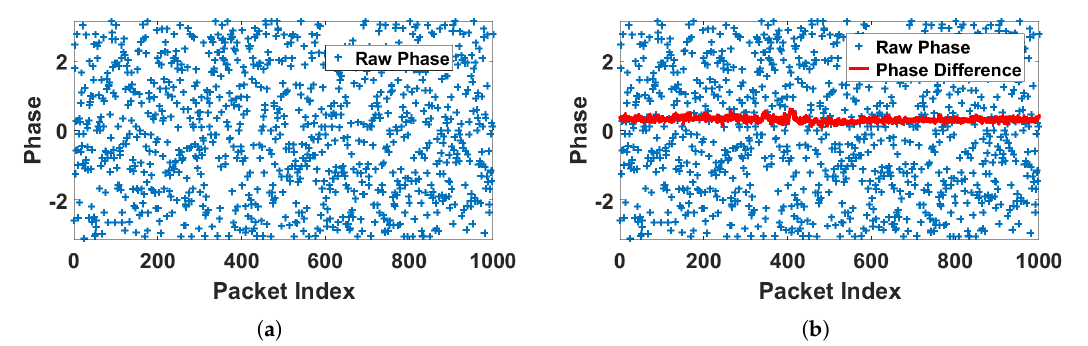
Figure 6. Raw phase and phase difference when no human appears in the current indoor environment. From ( a ) we can see the raw phases obtained by commodity wireless NIC distribute randomly which can not be used directly, while the raw phase can be calibrated phase difference as shown in ( b ).